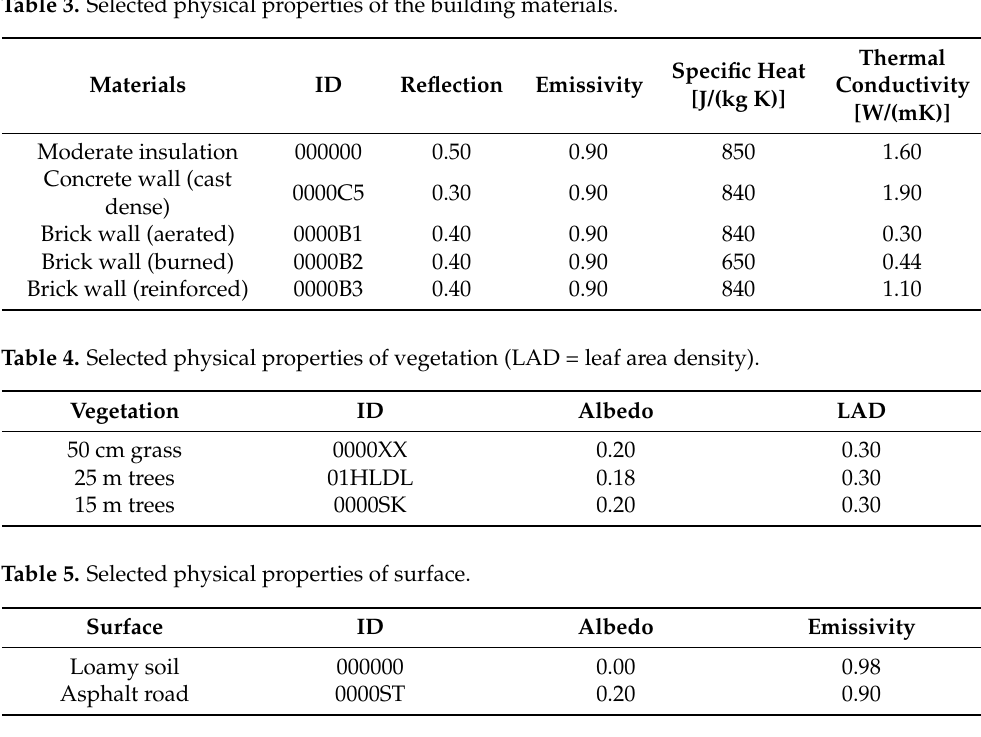
Table 3. Selected physical properties of the building materials.